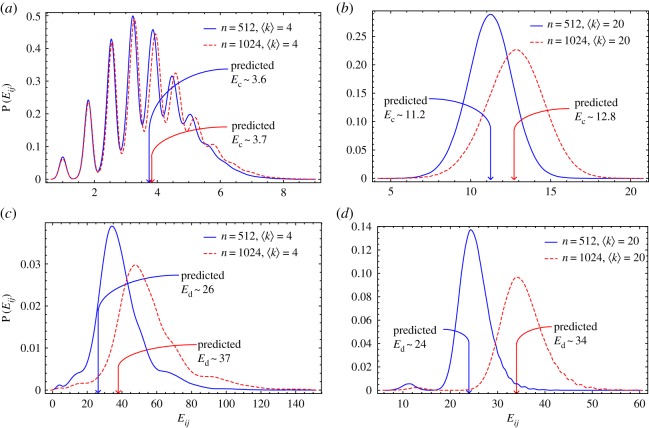
The distribution of Eij split into cases where i and j are directly connected in (a,b) and not directly connected in (c,d) for ER networks with N = 512 and 1024 and with 〈k〉 = 4 (a, c) or 〈k〉 = 20 (b,d). Note the changing axes in all figures. The predicted average of Ec (equation (A 5)) and Ed (equation (A 4)) are marked using the same colour schemes as in the figures. For 〈k〉 = 20, there is excellent agreement between the theoretical and simulated means. For 〈k〉 = 4, the GENs are far more heterogeneous due to the larger relative fluctuations than can be captured using the simple model in equations (A 4) and (A 5), and the theoretical predictions do not agree well with the observed behaviour for both connected and disconnected nodes.